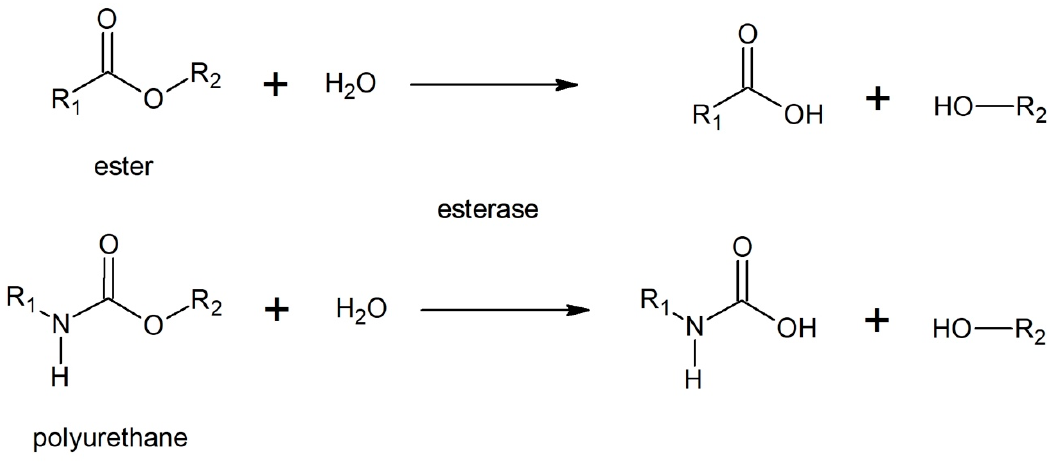
Figure 7. Hydrolysis of ester and polyurethane by esterase.